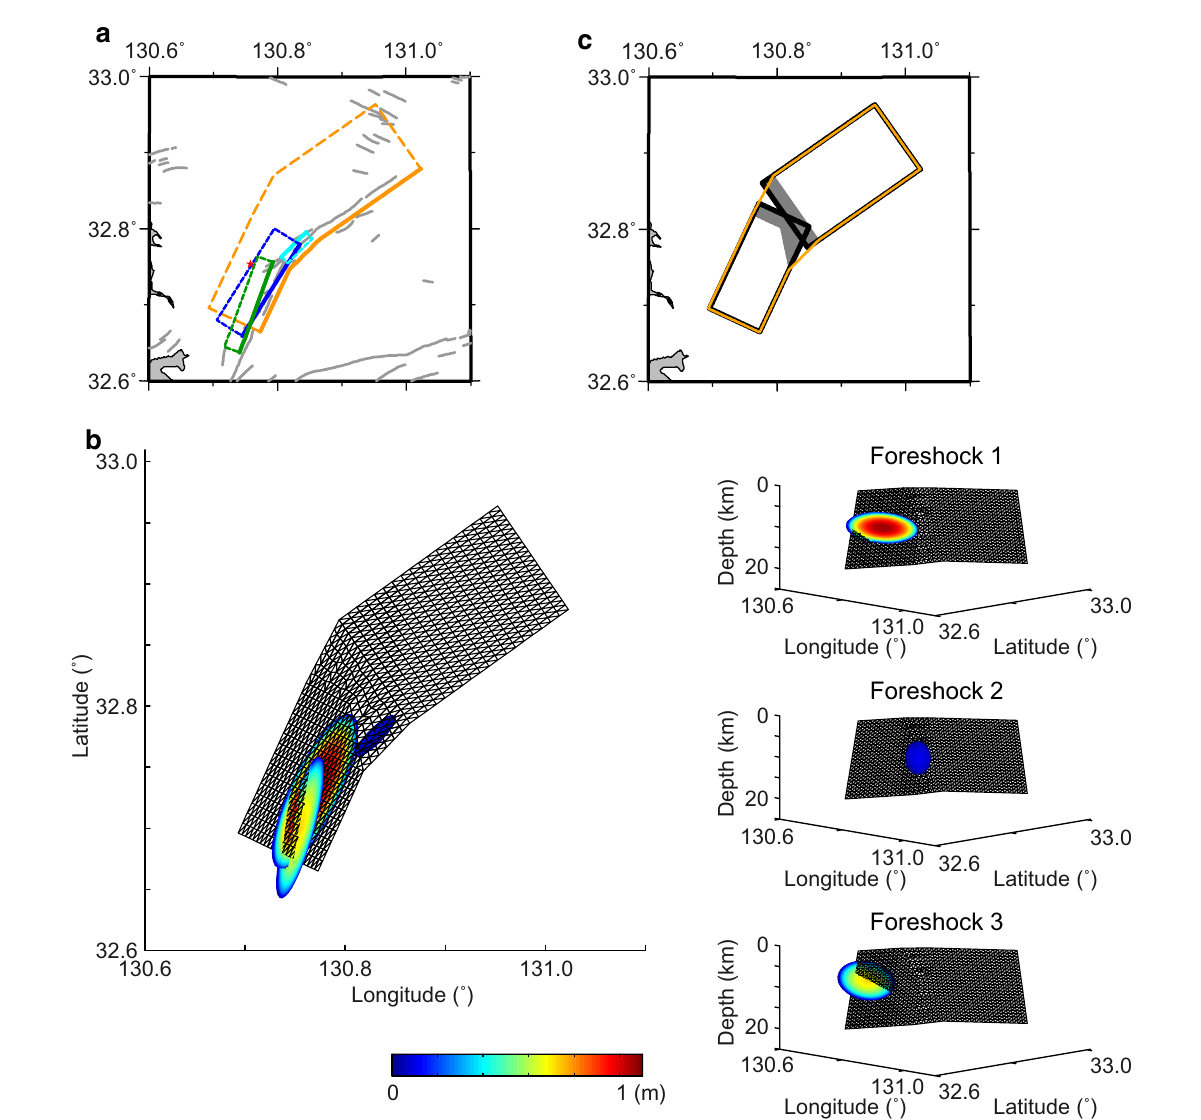
Fig. 4 a Estimated fault planes of the foreshocks (blue, light blue, and green lines) and a non-planar fault model of the main shock used in dynamic rupture simulations (orange lines). The fault planes of the foreshocks are the same as those shown in Fig. 2, and the main shock fault surface was built by connecting the estimated fault planes of the main shock shown in Fig. 2. Red star denote the epicenter of the main shock. b Assumed slip distributions of the three foreshocks in the map view (left panel) and in the view from the southeast (right panels). Black lines show triangular ele- ments of a non-planar fault used in dynamic rupture simulations of the main shock. c How to generate the single fault interface (orange lines) from the two estimated fault planes of the main shock (black rectangles). The orange lines and the black rectangles are the same as the orange lines in ( a ) and the orange rectangles in Fig. 2a, respectively. The elements indicated by gray were removed at the connecting edges of the two fault planes, and fault elements were filled between both edges forming a non-planar fault